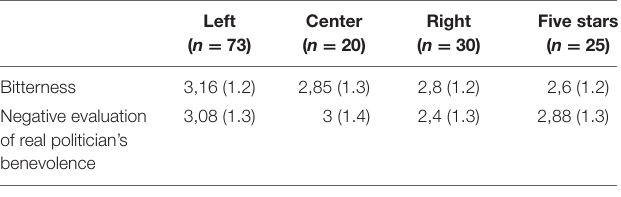
TABLE 4 | Descriptive statistics of bitterness and negative evaluation of the real politician’s benevolence (mean and SD).